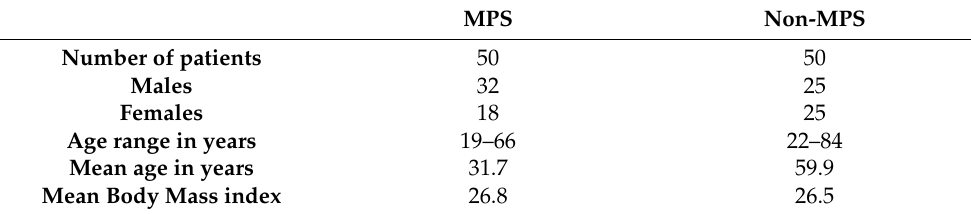
Table 2. Demographics of the study in both the MPS and non-MPS groups.